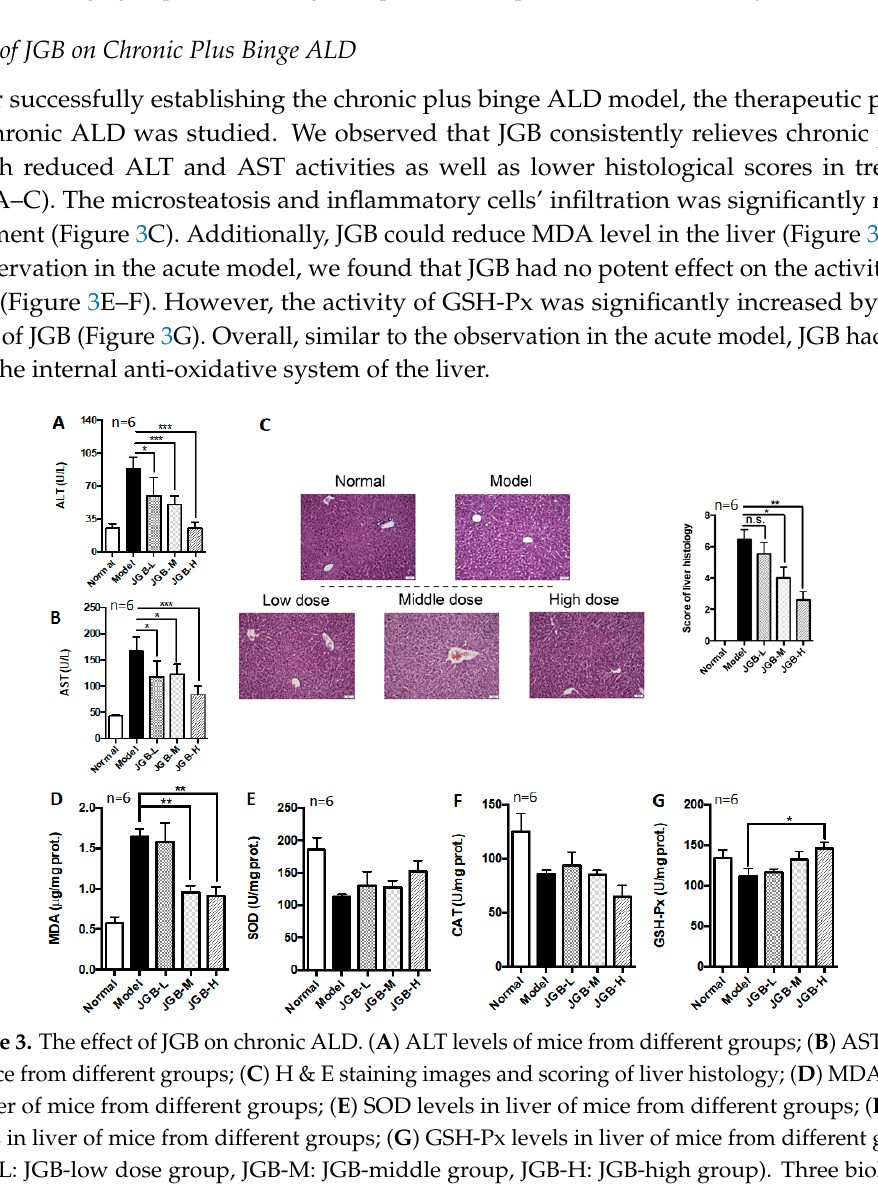
Figure 2. The curative effect of JGB on acute ALD. ( A ) Serum ALT levels of mice from different groups; ( B ) Serum AST levels of mice from different groups; ( C ) H&E staining images and scoring of liver histology of mice from different groups. (JGB-L: JGB-low dose group, JGB-M: JGB-middle group, JGB-H: JGB-high group). Three biological replicates were performed for each study.